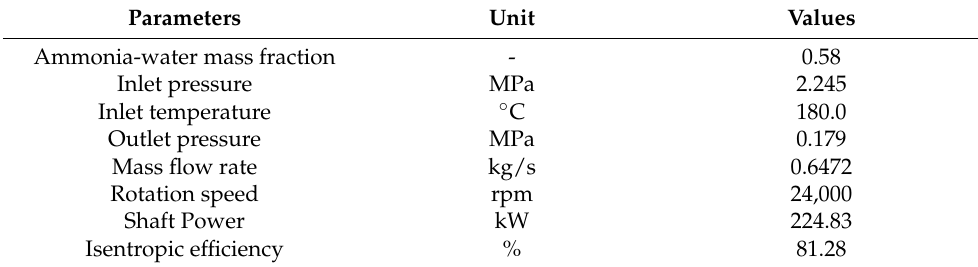
Table 1. Design parameters of the radial-outflow turbine.